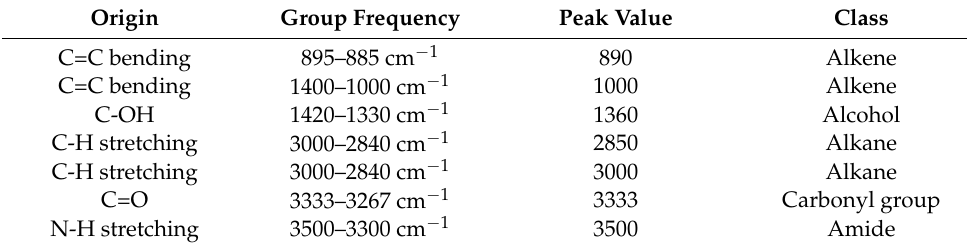
Figure 2. FT–IR spectrum of C. roseus leaves extract and silver nanoparticles. Table 1. Functional groups of C. roseus extract identified by